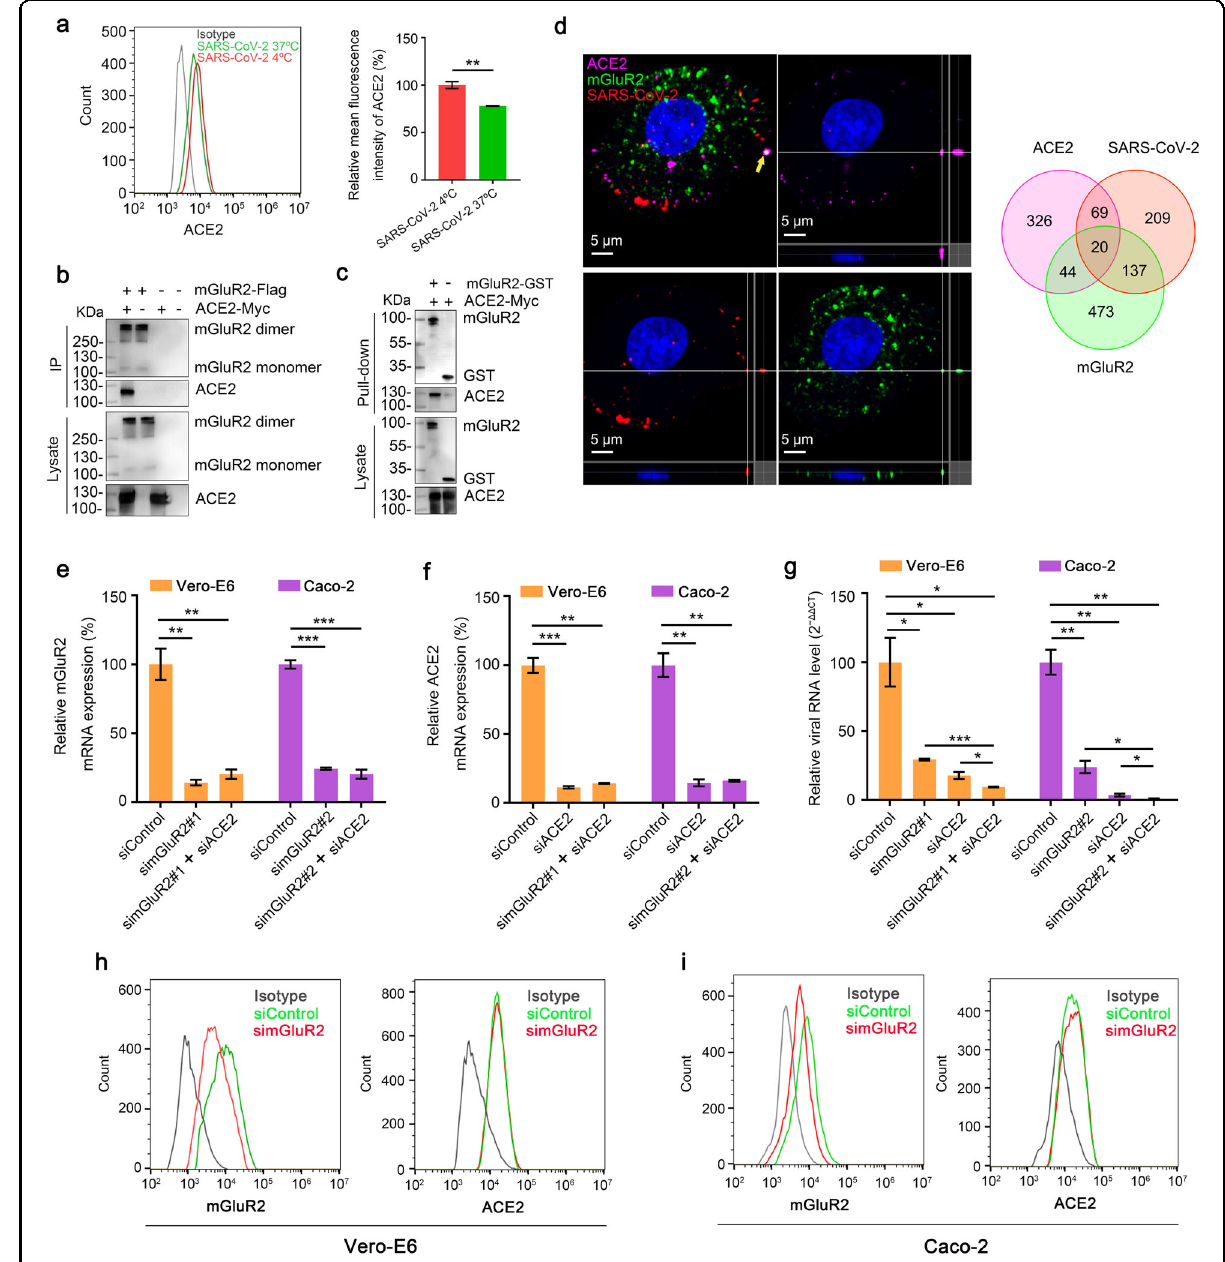
Fig. 3 mGluR2 interacts with ACE2. a The surface expression level of ACE2 was detected by using fl ow cytometry after infection with HRB25 at 37 °C for 30 min under unpermeabilized conditions in Vero-E6 cells. b HEK293 cells were co-transfected with mGluR2-Flag and ACE2-Myc. Cell lysates were immunoprecipitated by using anti-Flag agarose beads. c mGluR2-GST was pooled with lysate from ACE2-Myc-transfected HEK293 cells and then pulled down by using anti-GST beads. d Multiplex immuno fl uorescence was performed in Vero-E6 cells. Colocalization of mGluR2 (green), SARS-CoV- 2 N protein (red), and ACE2 (purple) was observed and quanti fi ed. The yellow arrowhead indicates the representative colocalization of mGluR2 (green), SARS-CoV-2 N protein (red), and ACE2 (purple), shown in three dimensions. e , f Knockdown of mGluR2 ( e ) or ACE2 ( f ) was measured by use of qPCR in Vero-E6 cells and Caco-2 cells. simGluR2#1 and simGluR2#2, siRNAs speci fi c for mGluR2 mRNA from monkey and human, respectively; siACE2, siRNA speci fi c for ACE2; siControl, scrambled RNA. g mGluR2-silenced, ACE2-silenced Vero-E6 cells, or Caco-2 cells were infected with HRB25. At 24 h p.i., virus in the cell lysate was detected by use of qPCR. h , i The cell surface expression of mGluR2 or ACE2 in mGluR2-silenced Vero-E6 cells ( h ) or Caco-2 cells ( i ) was detected by fl ow cytometry. The data shown are representative results from three independent experiments ( a , e – g n = 3), means ± SD, Student ’ s t -test, *P < 0.05, **P < 0.01, ***P <